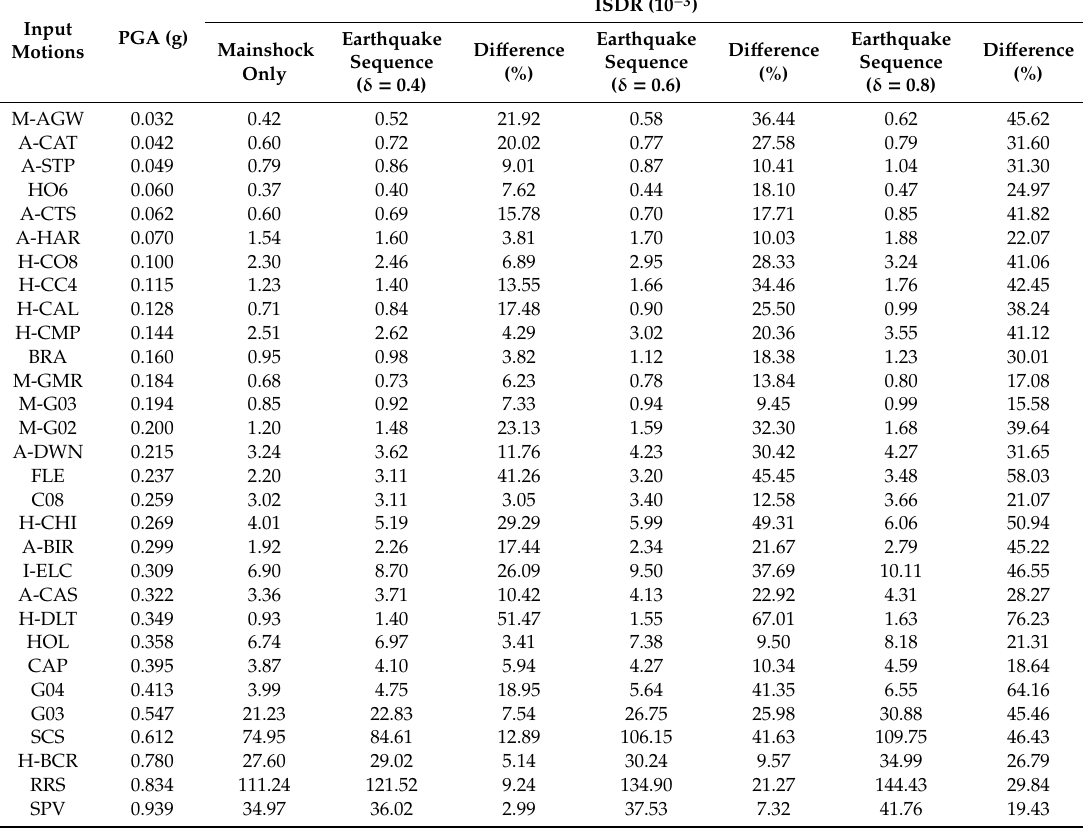
Table 4. Maximum ISDR under mainshock and earthquake